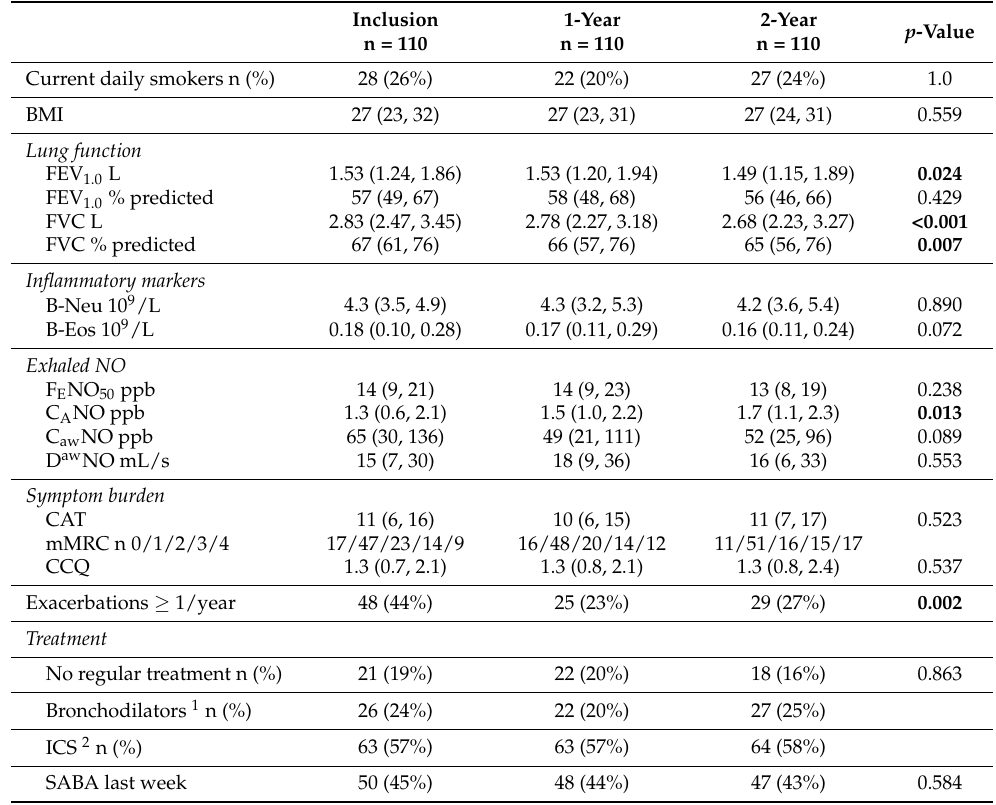
Table 2. Characteristics of the subjects completing the study at inclusion, and their one and two-year follow-ups.